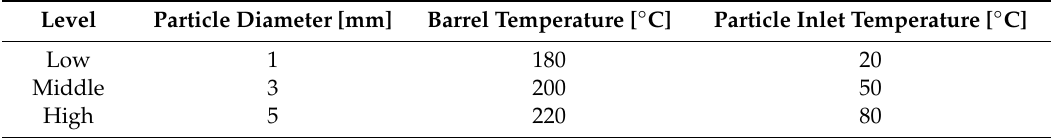
Table A2. Additionally varied for each of the points of Table A1 with one factor at a time method. Level